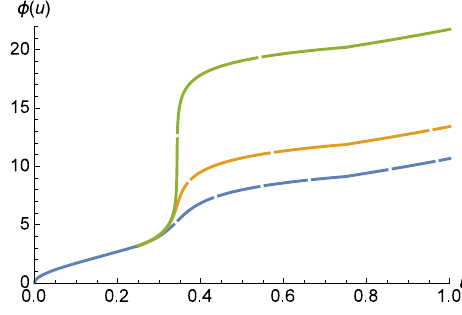
Figure 7. Coordinate φ [ u ] as function of u as the body falls onto the fast-rotating black hole for √ parameters a = − 0.5 and j = 1 + 2 − β where β = 10 − 2 (lower), 10 − 3 (middle) and 10 − 6